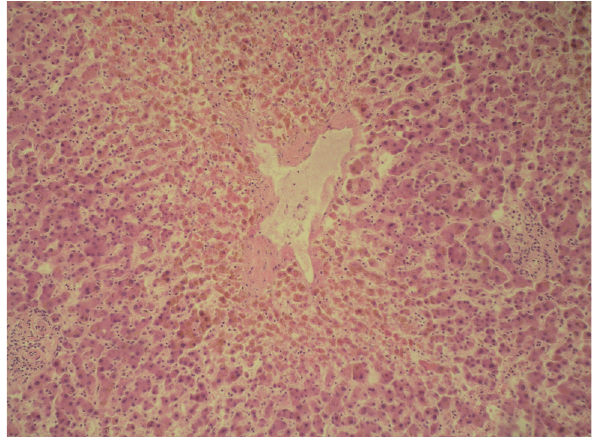
Fig. 1. Central necrosis in AHF (liver autopsy). Original mag- nification x400, hematoxylin-eosin stain (Courtesy of Dr. Lenz, St. Anne’s Faculty Hospital, Brno, Czech